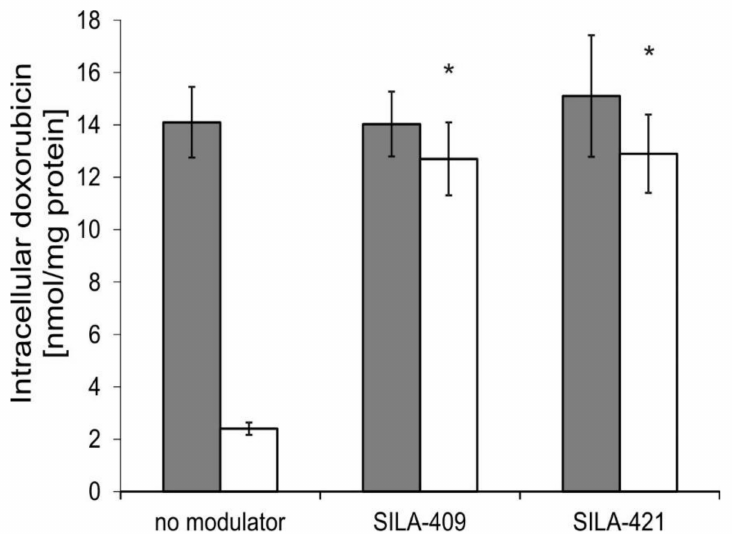
Figure 4. Intracellular doxorubicin (Dox) accumulation in LoVo (gray bars) and LoVo / Dx cells (white bars) treated with SILA-409 and SILA-421 at 5 µ M concentration. Means ± SD of three experiments are presented. The statistically significant di ff erences between untreated and disiloxane-treated cells were determined using Student’s t -test (* p <